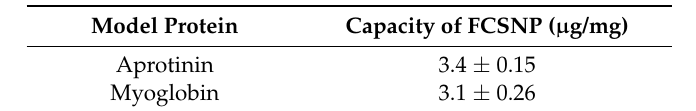
Table 3. Capacity of the nanoparticles. FCSNP were incubated with different model proteins. Values are expressed as mean ± standard deviation (SD) from measures by triplicate.